Question: Which kind of chart has been used to present this data?
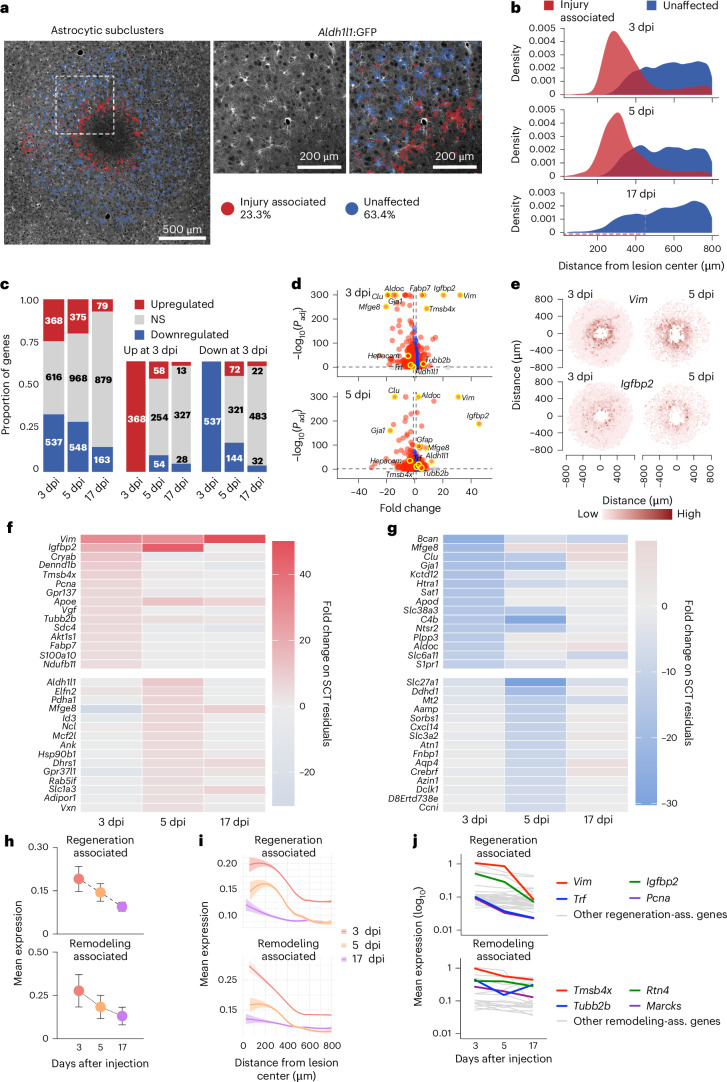
Answer: heatmap